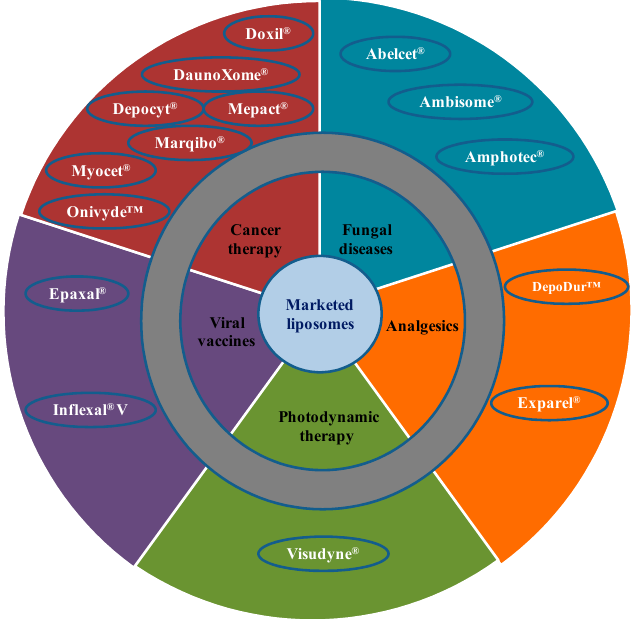
Figure 2. Therapeutic areas covered by liposome-based products.